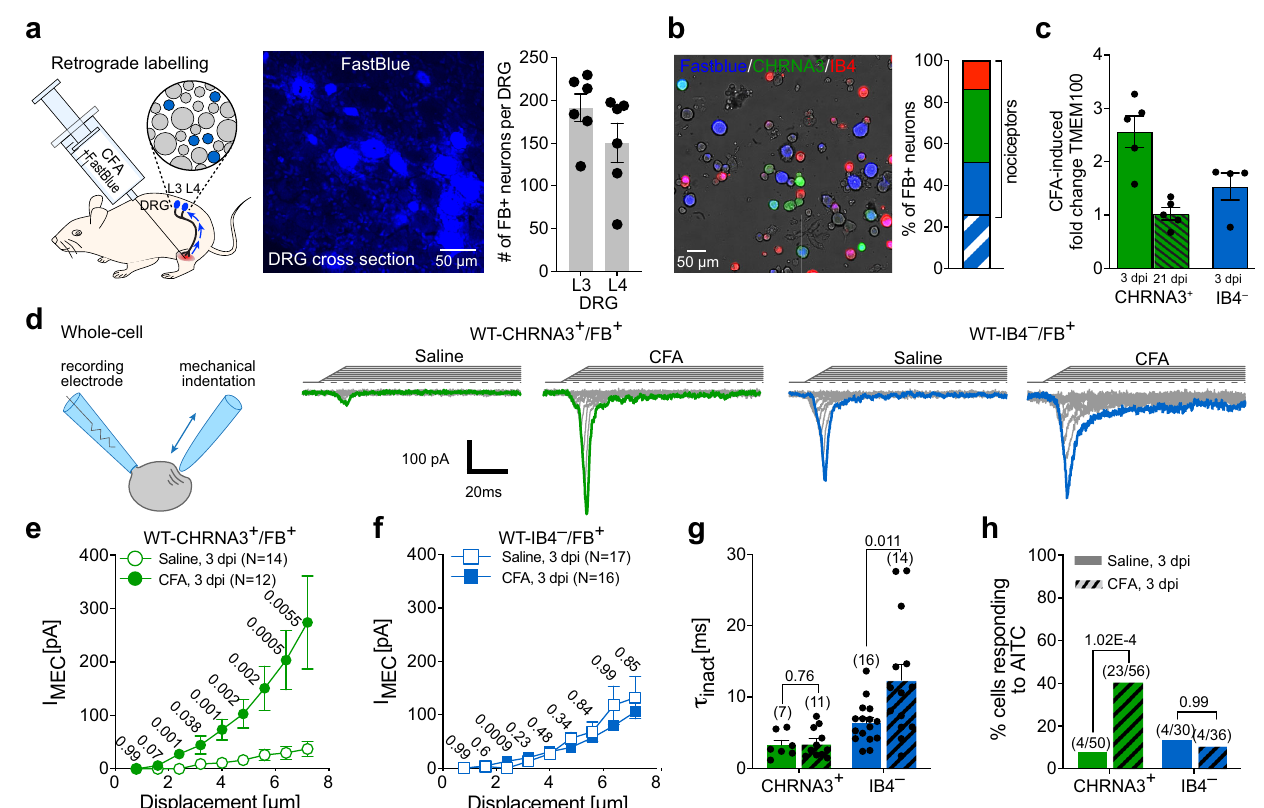
Fig. 3 | CFA-induced knee joint in fl ammation induces mechanosensitivity and potentiates TRPA1 activity in CHRNA3-EGFP + afferents. a Cartoon depicting retrograde labeling of knee joint afferents (left), example image of FB + neurons in DRG section (middle) and quanti fi cation of the mean±SEM numbers of FB + neu- ronsinL3andL4DRGsfrom6mice.DotsrepresentindividualvaluesforeachDRG. b Exampleimage of aDRGculturefrom aCHRNA3-EGFPmouse afterintraarticular FB (left). Stacked bar graph (right) shows the proportions of IB4 + cells (non-pep- tidergic nociceptors, red), MIAs (green), peptidergic nociceptors (IB4 – ,<30 µ m, blue)andgroup-IIarticularafferents(IB4 – ,>30 µ m,bluehatched). c Quanti fi cation of CFA-induced changes in TMEM100 expression in FB-labeled MIAs and pepti- dergic nociceptors. Expression levels in ipsi- and contralateral DRGs (20 cells per sample),attheindicatedtimepoints,werecomparedbyqPCR( ΔΔ Ctmethod).Bars represent means±SEM and data from individual mice are shown as black dots (N=5 mice for 3 and 21 dpi in CHRNA3 + /FB + cells and N =4 for IB4 – /FB + cells). d Example traces of mechanically-evoked currents. e , f Comparison of the